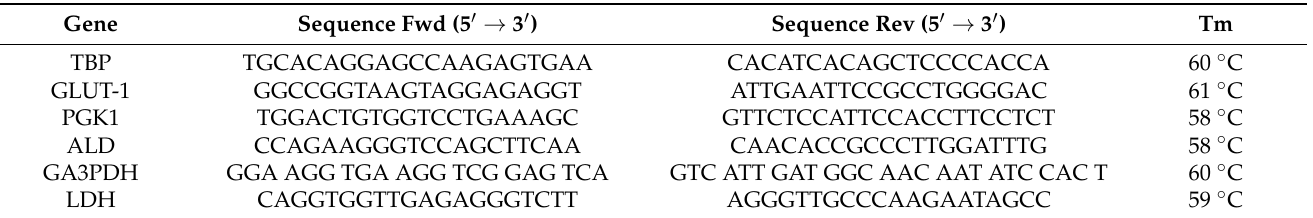
Table 1. Primer sequences used in RT-qPCR and temperature (Tm). The data for all the experiments are listed in Supplementary